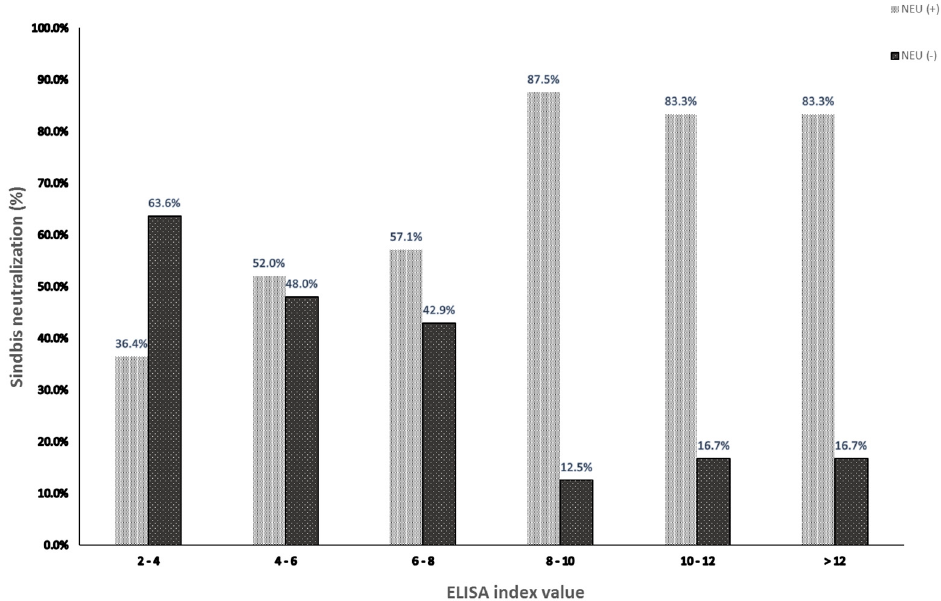
Figure 1. Neutralization of SINV ELISA IgG-positive samples. Serum neutralization assay was performed on 113 samples positive in the ELISA assay for SINV IgG. The samples were divided into six groups based on the ELISA index value. Percentages of samples neutralized by SINV [NEU (+)] or not [NEU (-)] are depicted. Table 2. Univariate and multivariate logistic regression analyses of demographic characteristics of individuals diagnosed with Sindbis virus by